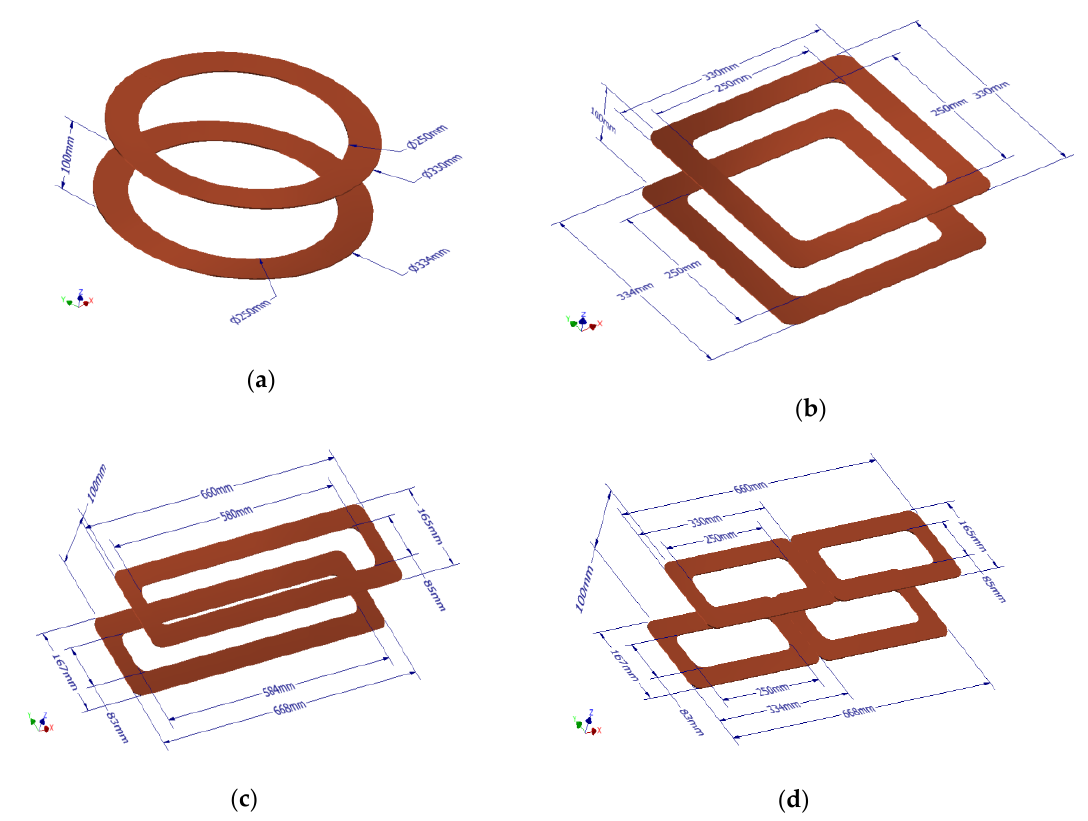
Figure 3. Diagrams of the different coil models: ( a ) circular; ( b ) square; ( c ) rectangular; ( d ) Double D (DD).